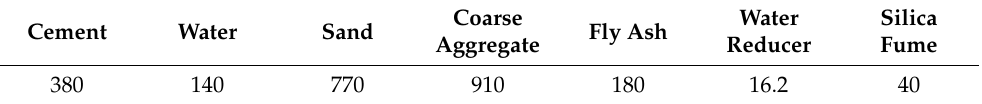
Table 1. Components and corresponding proportions of the SCC specimens (kg/m 3